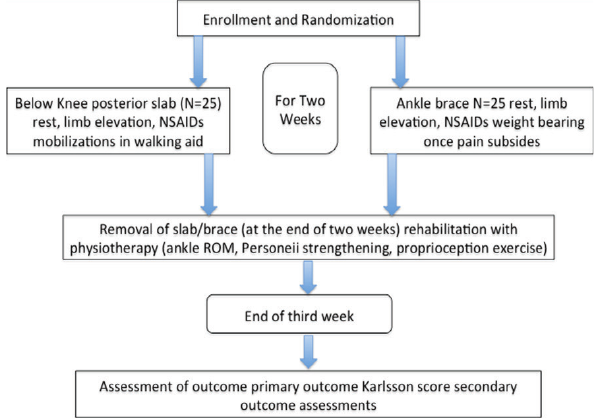
Figure 1: Consort diagram of the study Fifty patients presenting consecutively within 24